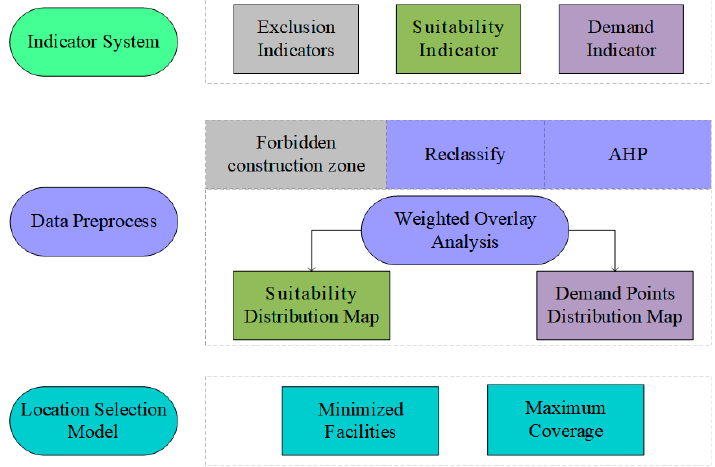
Figure 1. The process flow of the current study.